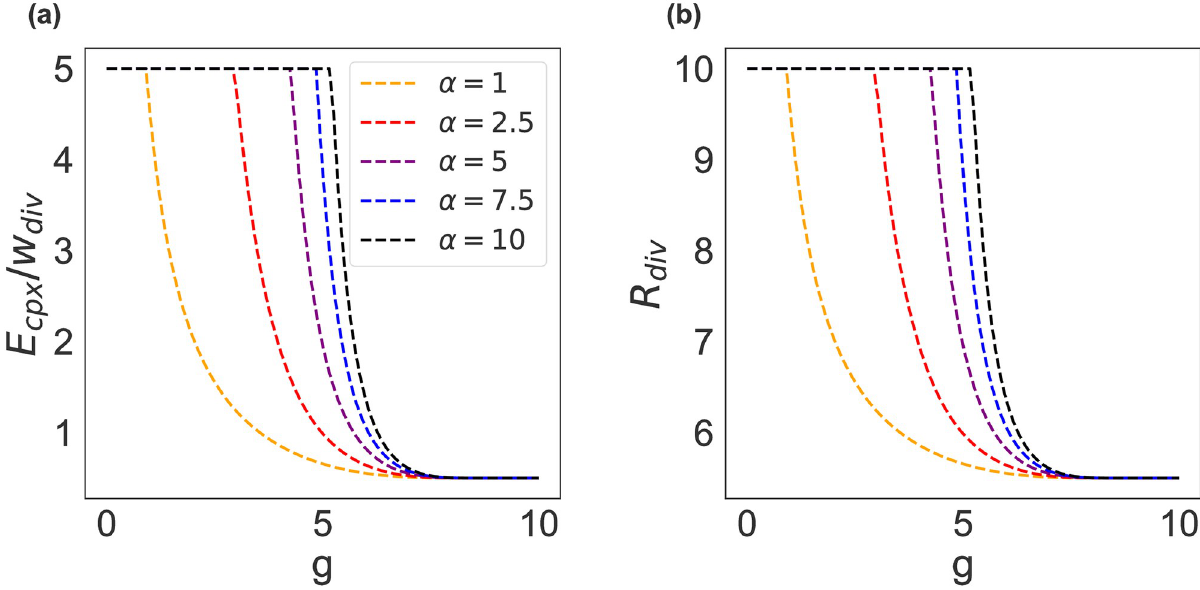
Fig 2. Effect of group unobserved characteristics α and general intelligence ( g ) on the need for representational diversity ( R div ). Panel (a) shows how the ‘environmental component’, E / w changes with g . A higher value of α indicates a higher incidence of restricted access to schooling and cpx div technology. Thus, much higher g is needed for an individual to understand a system and reduce the need for representational diversity. Panel (b) shows the effect of S , shifting the curves, on the need for representational diversity ( R ) and, thus, the overall R taking into account both environmental cpx div div and social complexity. Figure was generated keeping E cpx = S cpx =